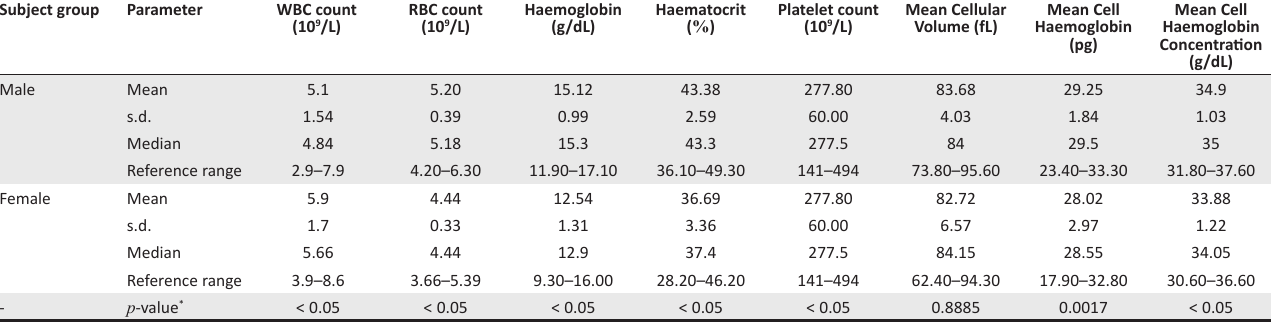
TABLE 5 : Means, medians and 95th percentile reference intervals for haematological parameters for 261 HIV-negative adults in Botswana.